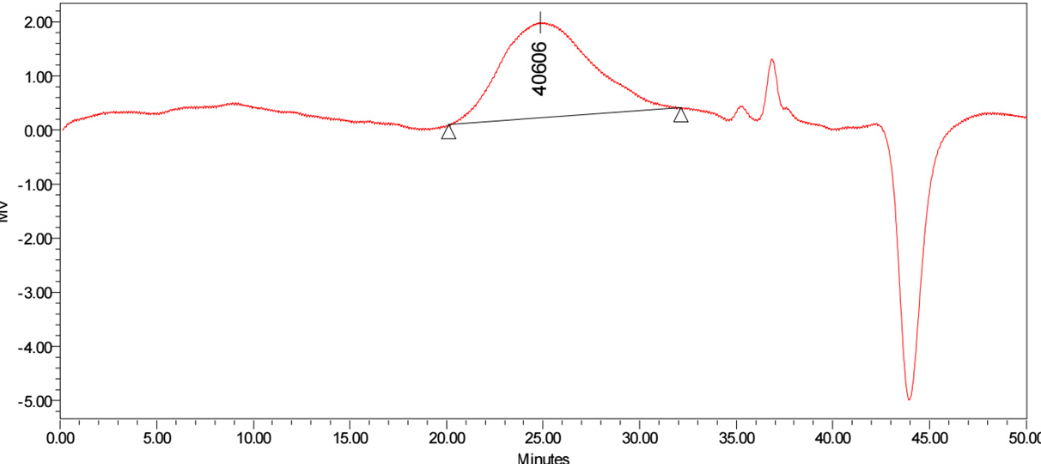
Figure 9. Size exclusion chromatogram showing molecular weight distribution of PHB produced by Priestia sp. strain JY310.